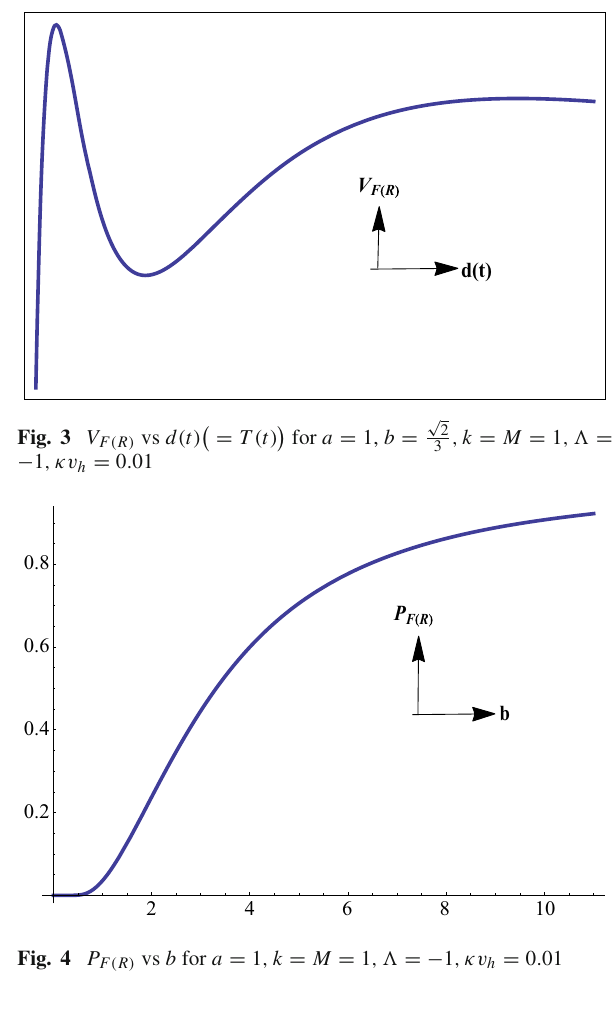
calculate the tunneling probability ( P F ( R ) ) from d = < d > + to d = 0 and is given